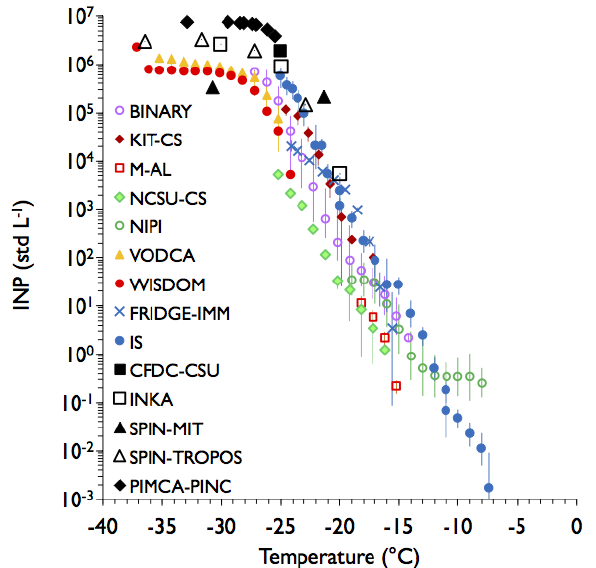
Figure 6. As in Fig. 4, but for sampling of K-feldspar particles from the APC. All distinguishing features discussed with regard to Fig. 4 apply here as well. The data herein correspond to FIN-02 APC ex- periments 13 and 14 on 19 March